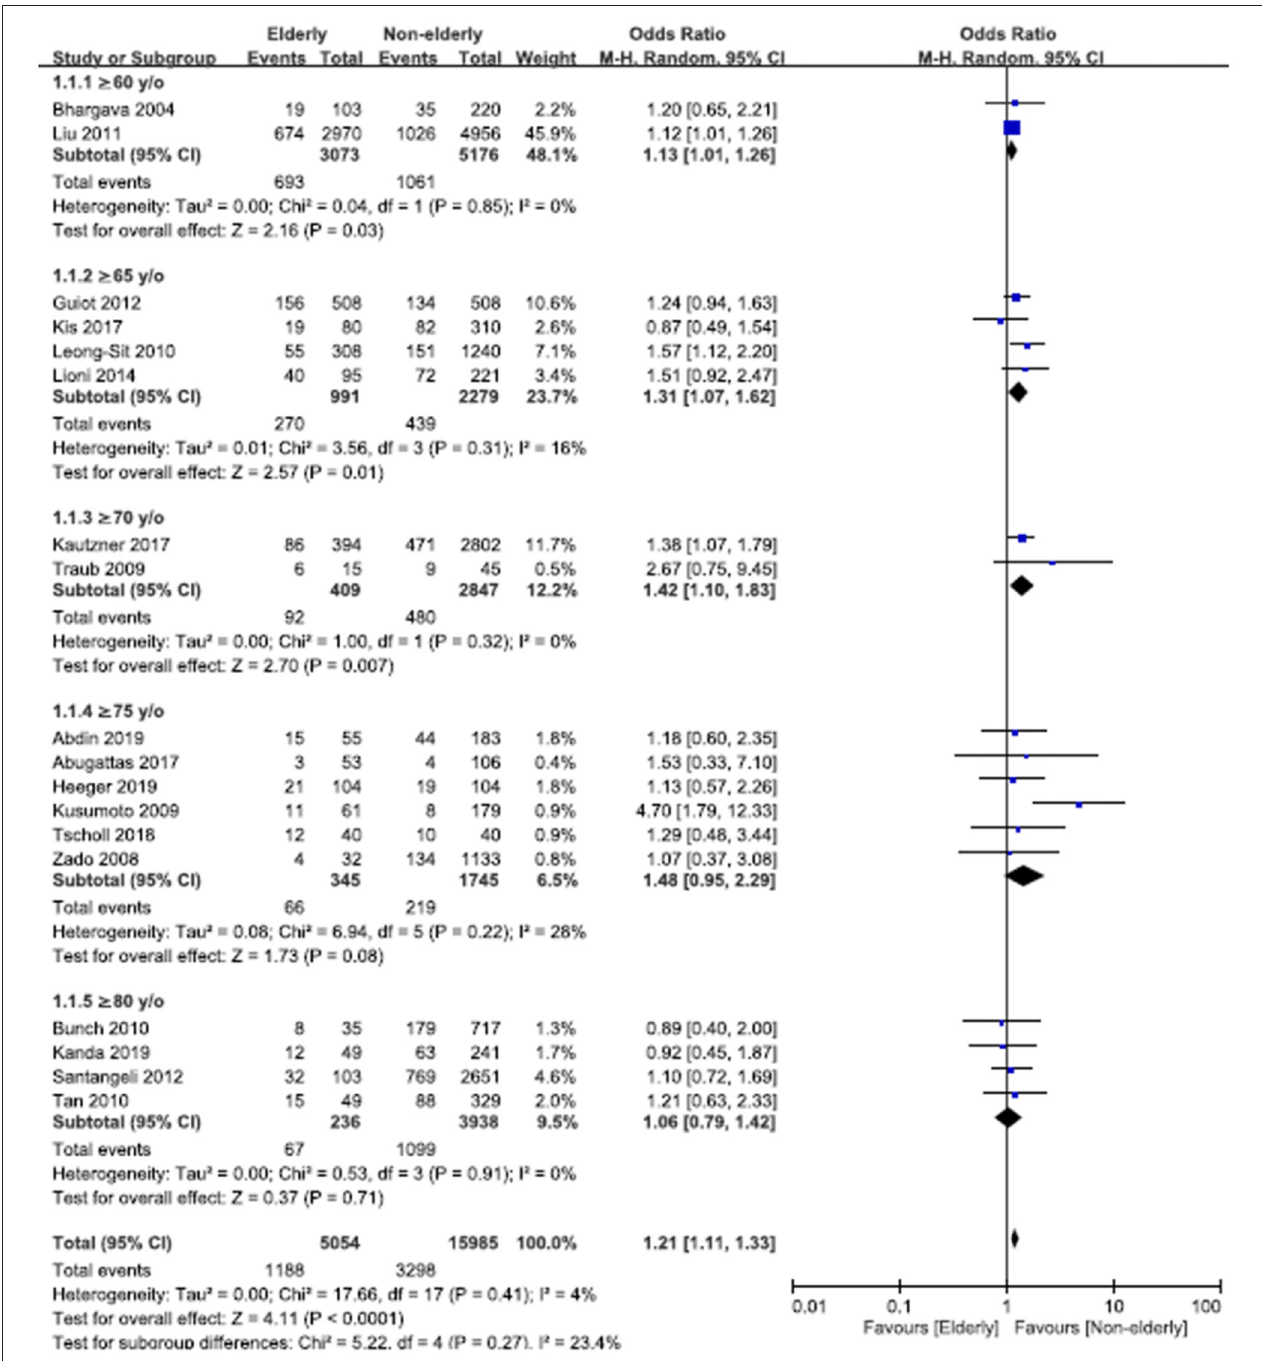
FIGURE 2 | Forest plots of the overall odds ratio (OR) of recurrent atrial fibrillation (AF) or atrial tachyarrhythmia (ATA) after AF ablation between the elderly and non-elderly groups in the entire population with different age distributions from 18 studies. CI, confidence interval.